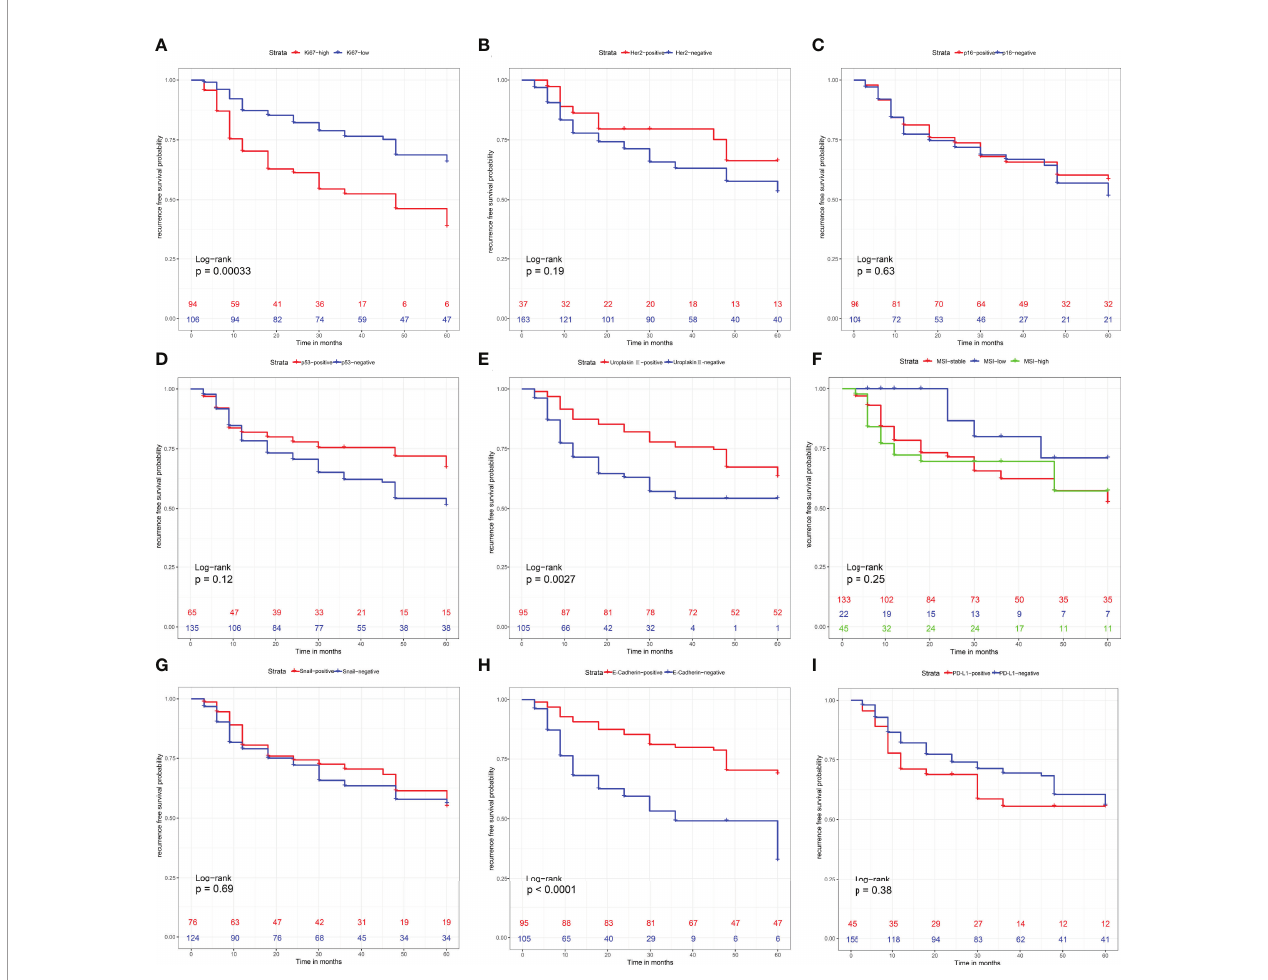
FIGURE 3 | Recurrence-free survival analysis with Kaplan-Meier method for patients divided by (A) Ki-67 expression level, (B) Her2 expression level, (C) P16 expression level, (D) P53 expression level, (E) Uroplakin III expression level, (F) Microsatellite instability status, (G) Snail expression level, (H) E-Cadherin expression level and (I) PD-L1 expression level. P values were determined using the log-rank